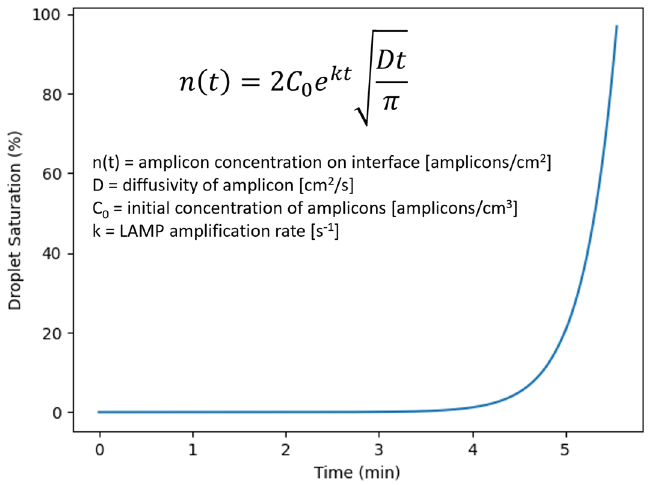
Figure 8. Theoretical model equation and modeling results of LAMP amplicon creation and subsequent adsorption to the oil–water interface within the emulsified